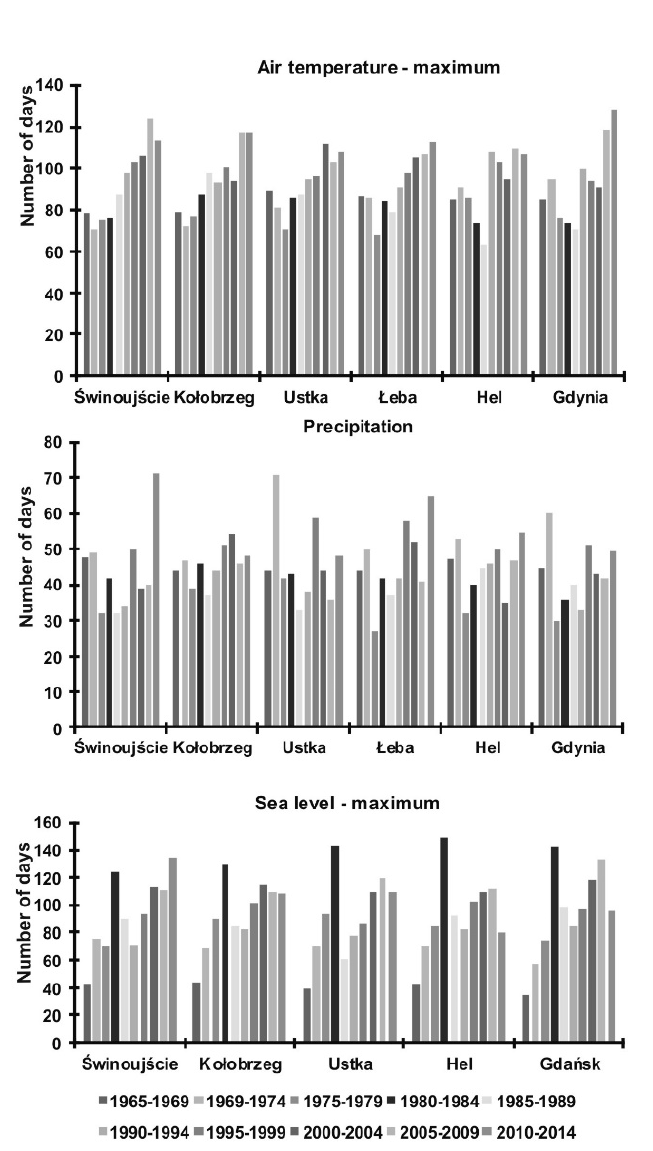
Figure 5. Temporal and spatial variability of the occurrence of extreme hydrometeorological events in the Polish coastal zone of the Baltic Sea.